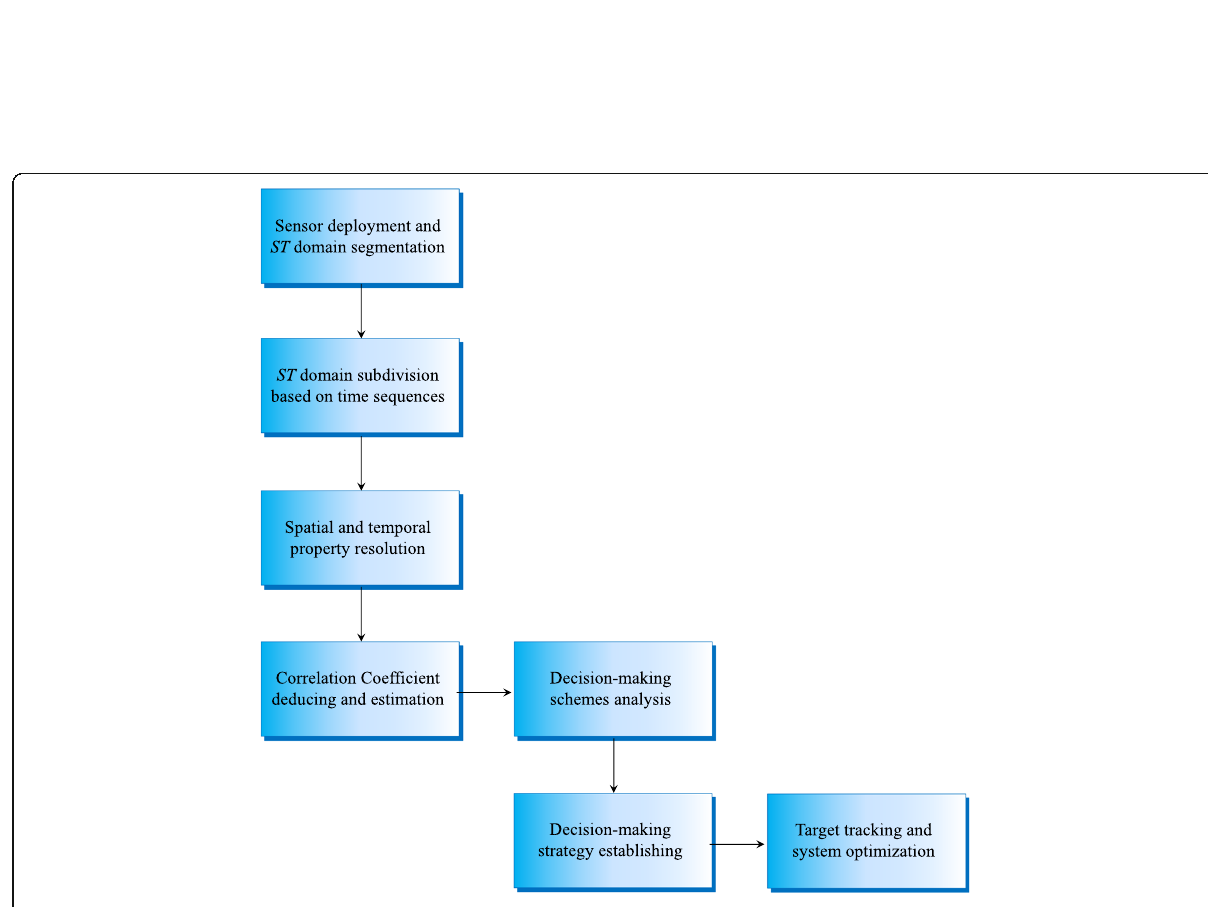
Fig. 7 Block diagram of proposed system working procedure. Both detecting and interpreting a target from the spatial and temporal characteristics corresponding to the three-dimensional responses in Fig.